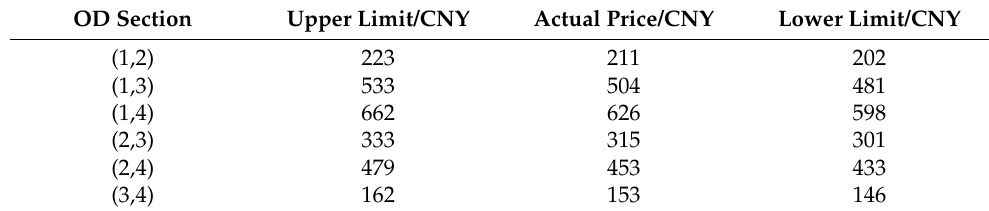
Table 4. Table of upper and lower prices for each OD section.